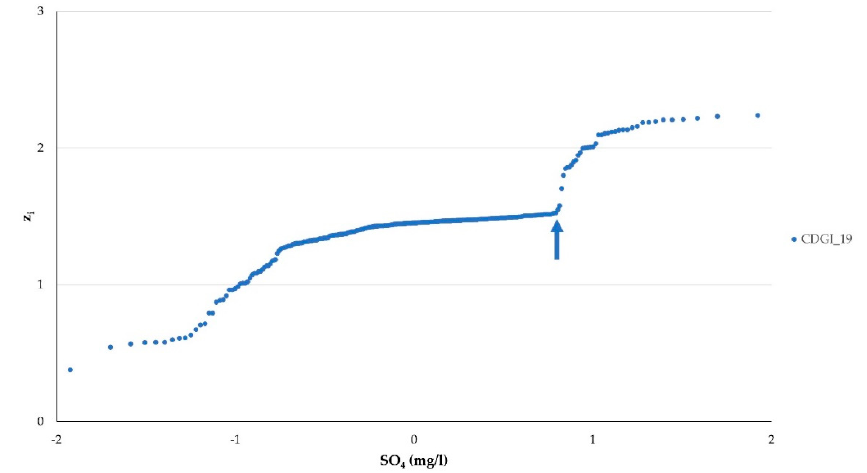
Figure 10. Lognormal probability plot of sulphate (SO 4 ) for the groundwater body CDGI_19. Arrow indicates inflection point that separate ambient and non-ambient populations.